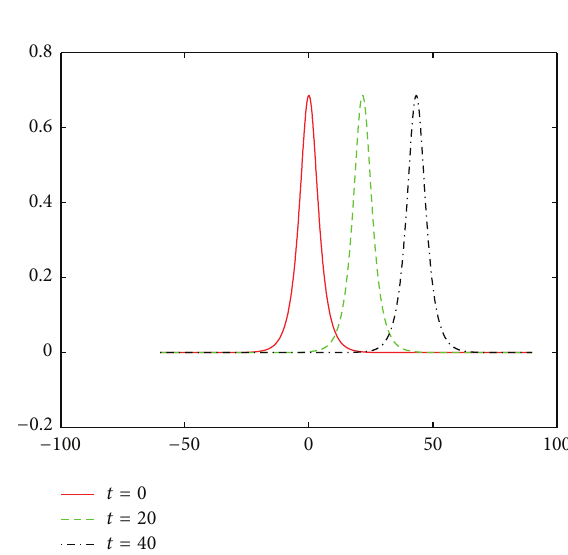
Figure 2: When 𝑝 = 5 and 𝜏 = ℎ = 0.125 , the wave graph of 𝑢(𝑥, 𝑡) at various